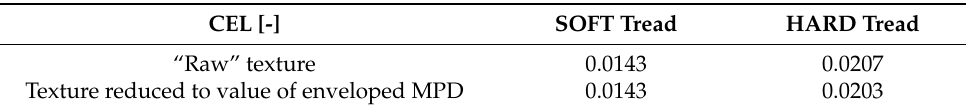
Table 2. Comparison of CEL for tested slick tires tested on raw APS sample and APS sample with reduced texture.